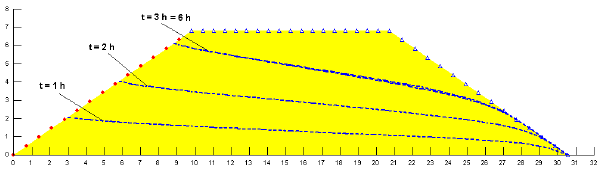
Figure 11 - Saturation level in the embankment at different times in the hypothesis of 5 homogeneous embankment. 6 Fig. 11. Saturation level in the embankment at different times in the hypothesis of homogeneous